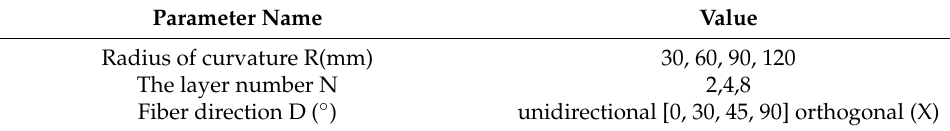
Table 1. Different FML structures parameter